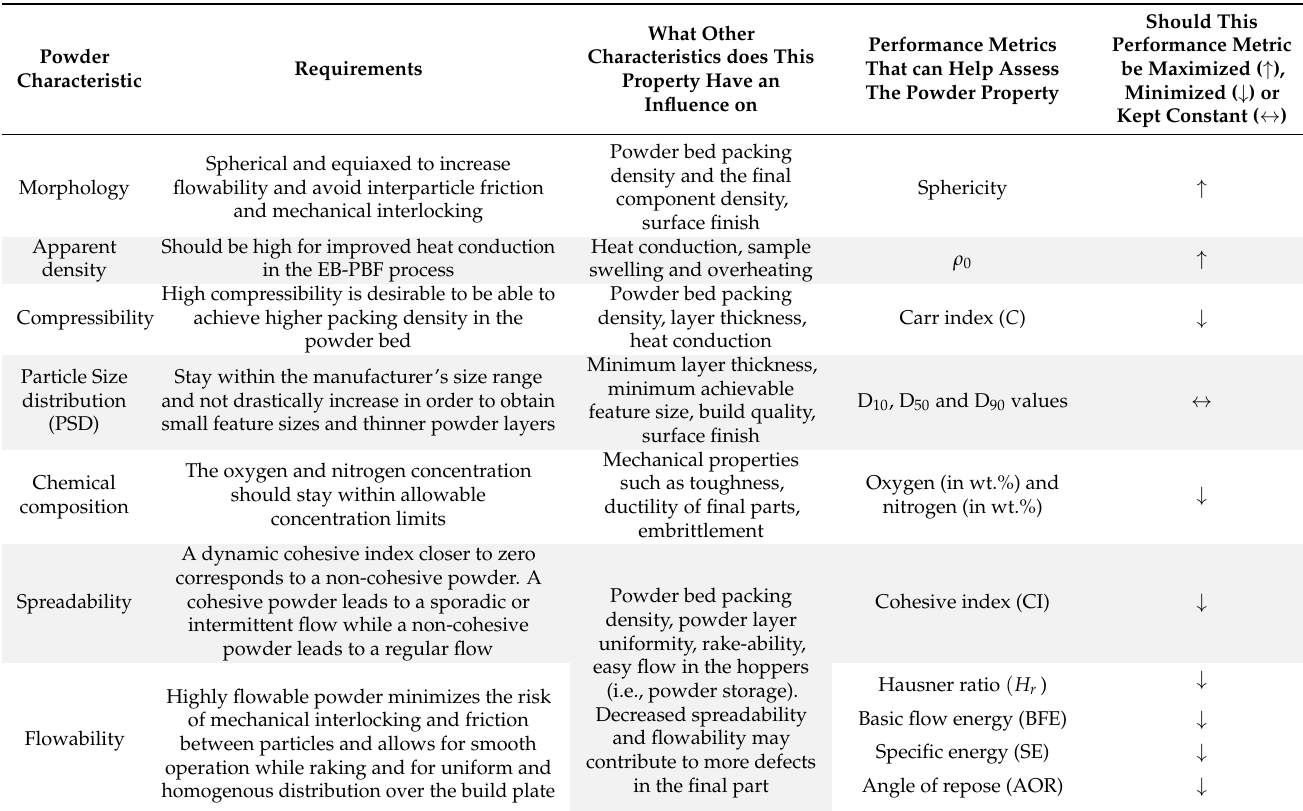
Table 1. Powder suitability criteria for use in the EB-PBF